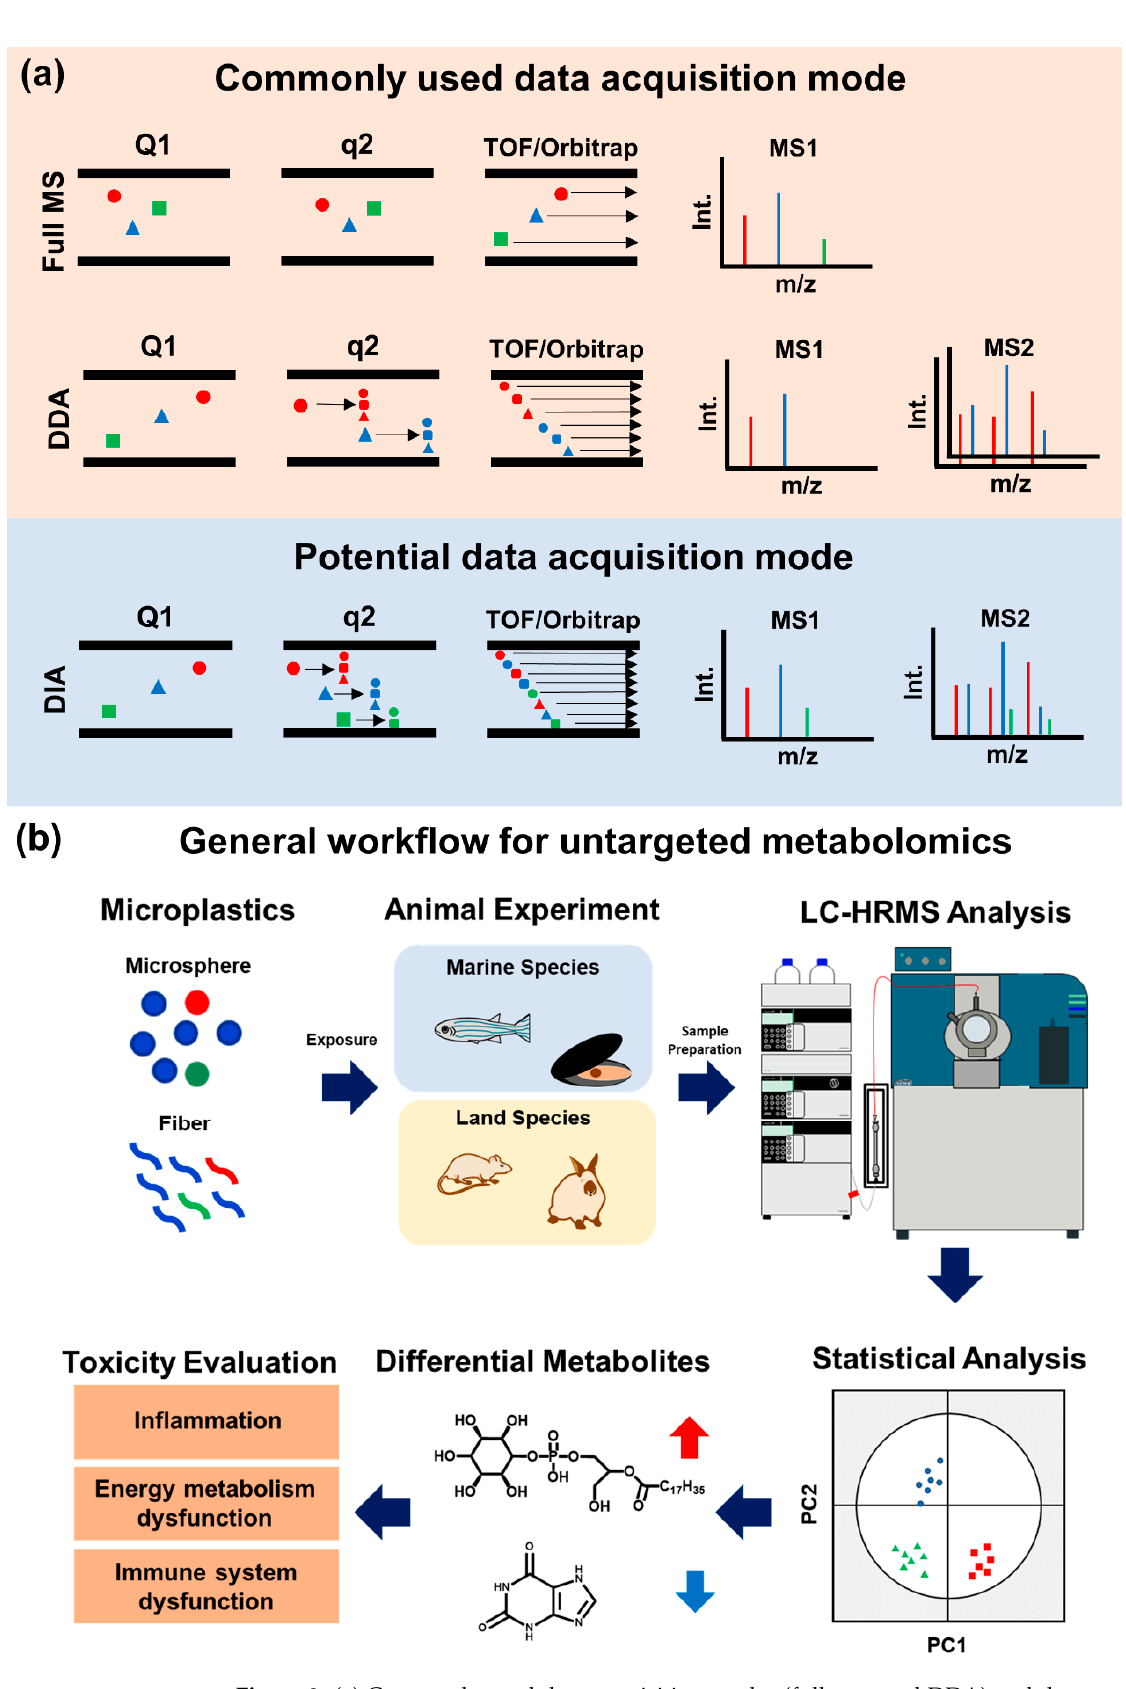
Figure 2. ( a ) Commonly used data acquisition modes (full scan and DDA) and the potential data acquisition mode. ( b ) The general work fl ow of the MPs-induced untargeted metabolomics.